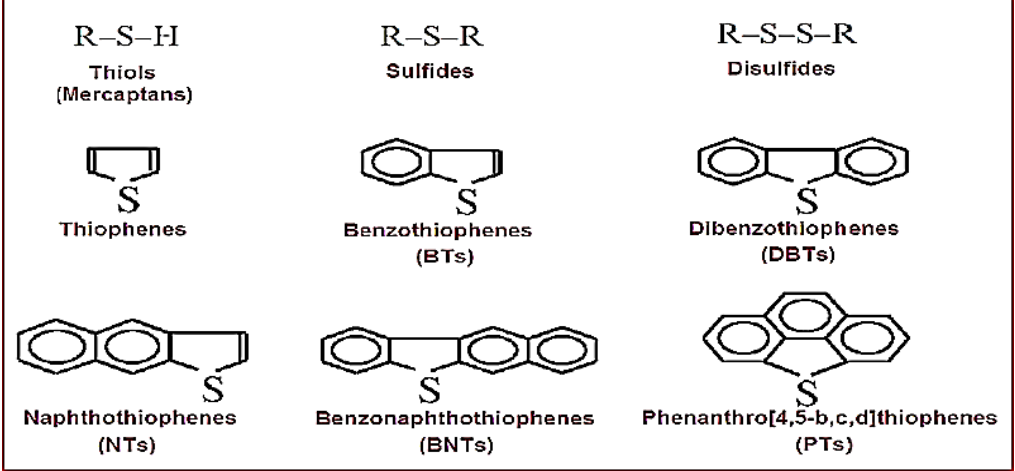
Figure 1: Typical forms of sulfur compounds